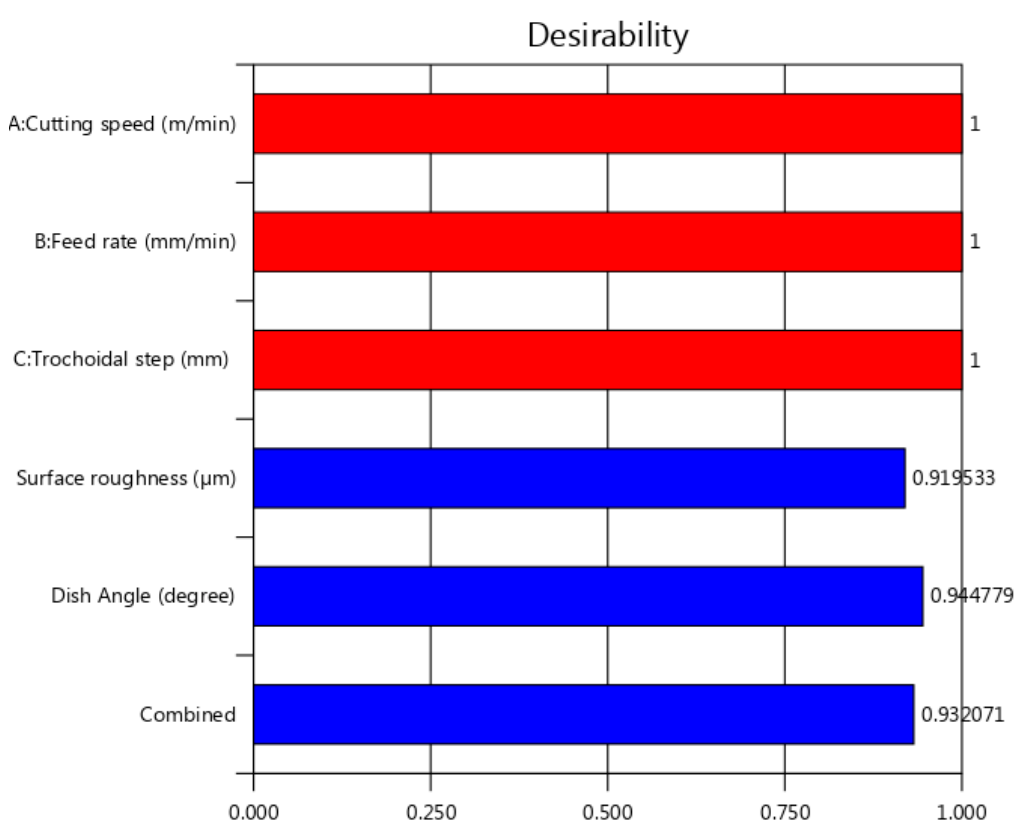
Figure 12. Ramps of numerical optimization. Materials 2019 , 12 , x FOR PEER REVIEW